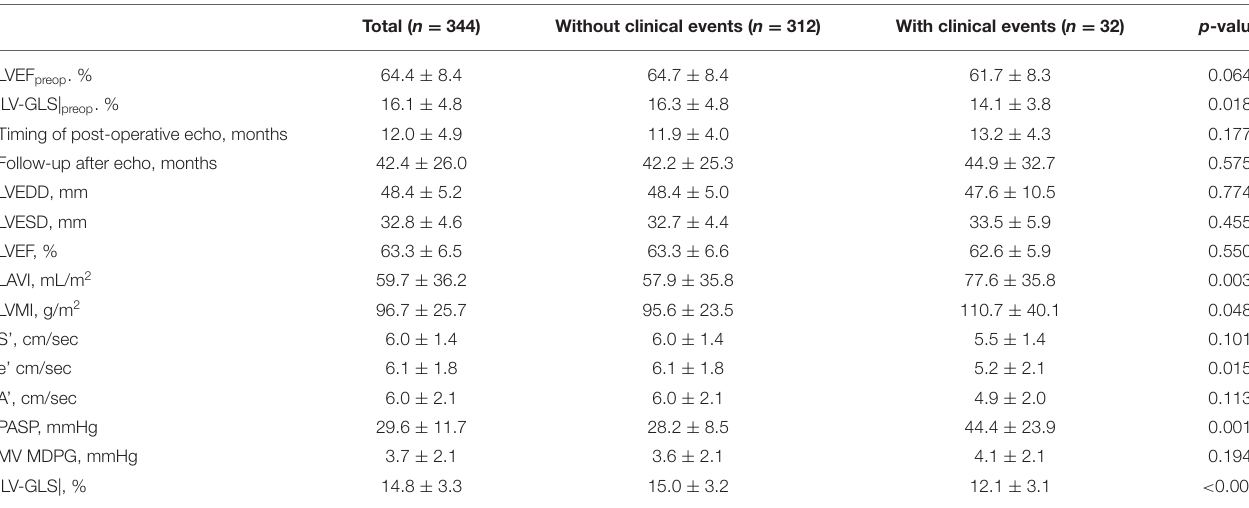
TABLE 2 | Echocardiographic parameters and left ventricular global longitudinal